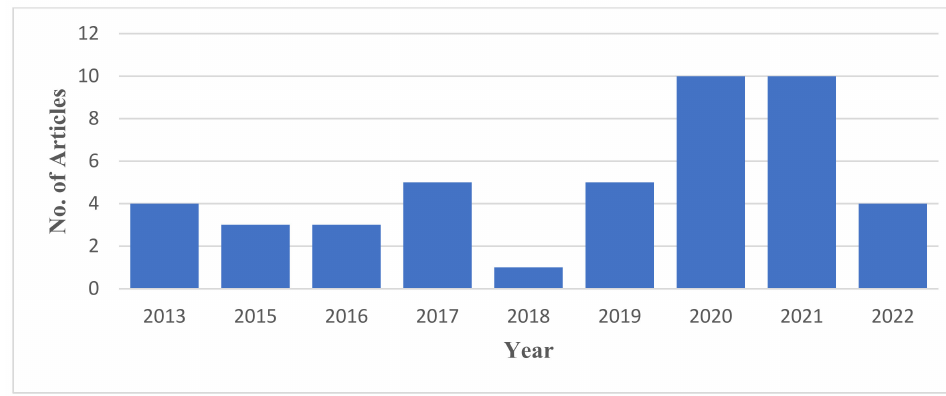
Figure 3. Publications per year.